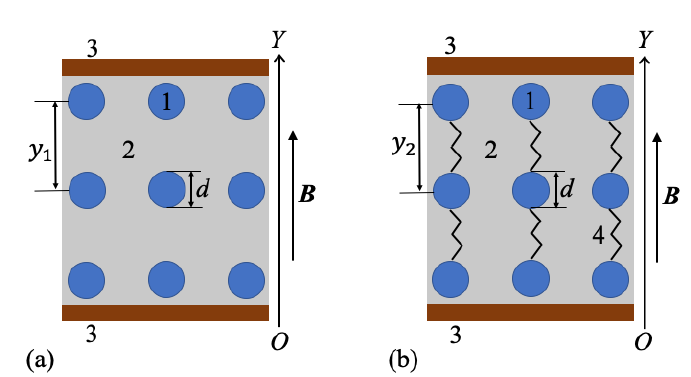
Figure 9. The equivalent electrical circuit of ED. C p —equivalent electrical capacitance; R p —equivalent electrical resistance; u —electrical voltage generated by the internal source of the impedance meter. When a magnetic field with flux density of about 25 mT is applied, CI form chain-like aggregates. The equivalent schematic structure is shown in Figure 10.